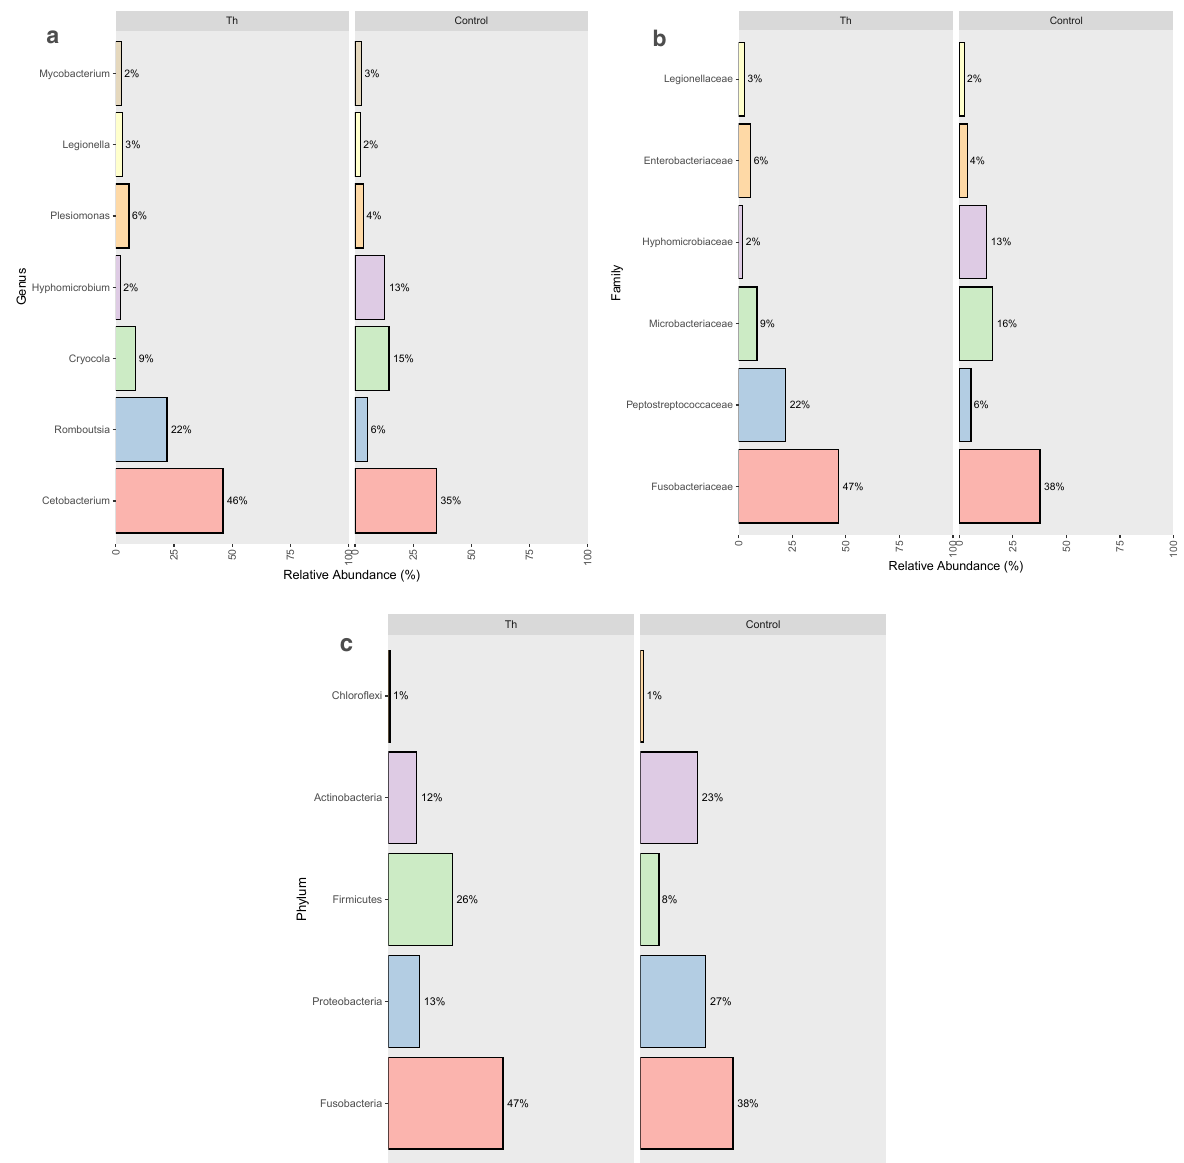
Figure 1. Bacterial relative abundance Nile tilapia ( Oreochromis niloticus ) fed a supplemented hydrolate diet from Curcuma longa . (Control). a, Genus; b, Families; c,